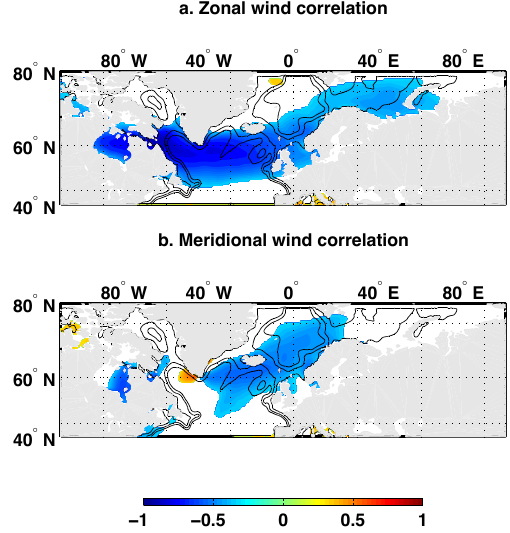
Figure 6. Correlation coefficients between the expansion coeffi- cients of the leading empirical orthogonal function (Fig. 4b) and nonseasonal (a) zonal and (b) meridional ERA-Interim wind stress. Only values statistically significant at the 95% confidence level are shown. Thin black contours are as in Fig.